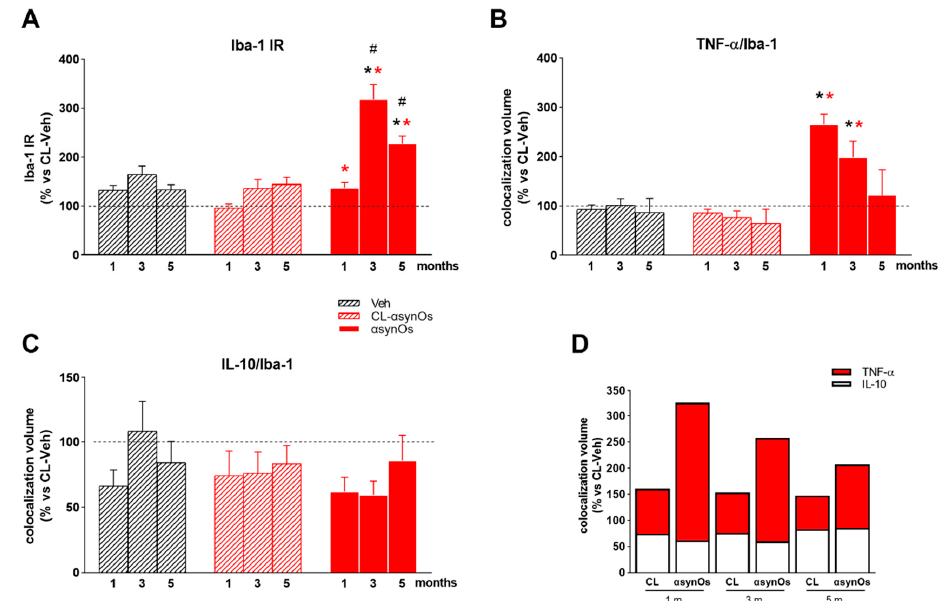
Figure 4. H- α SynOs induced reactive microgliosis and unbalanced cytokines expression in the SNpc. Total volumes occupied by Iba-1 ( A ), TNF- α , and IL-10 colocalized with Iba-1 + cells ( B,C ). Stacked bar chart shows the relative expression of TNF- α and IL-10 within Iba-1 + cells, which was unbalanced toward a proinflammatory phenotype following H- α synO-infusion ( D ). Values are expressed as a percentage of the contralateral (CL) side of the vehicle-injected animals, and represent the mean ± SEM. * p < 0.01 vs. Veh, * p < 0.001 vs. CL-H- α SynOs, # p < 0.0001 vs. H- α SynOs, one month by Tukey post-hoc test ( n = 100–120 per group, 4–5 animals per group).